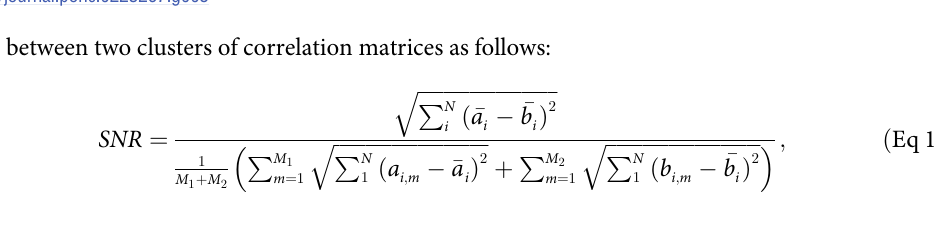
Fig 5. Explanation of increased variability of the simulated matrices. A- histograms of standard deviations of the elements of the simulated connectivity matrices for various q/n ; B- signal to noise ratio vs. q/n .